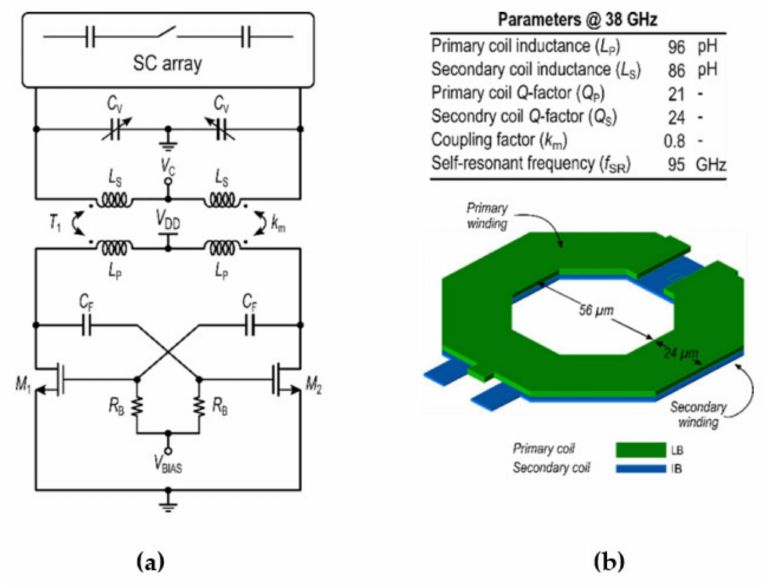
Figure 2. Voltage-controlled oscillator: ( a ) schematic, ( b ) 3-D view of transformer T 1 with the adopted metal stack and its main